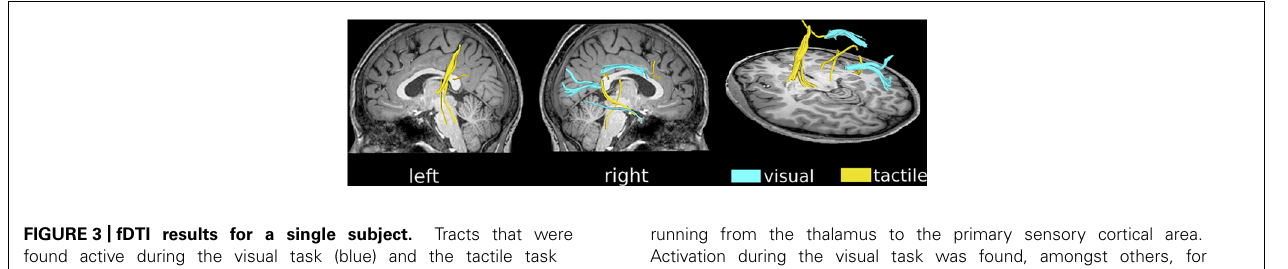
FIGURE 3 | fDTI results for a single subject. Tracts that were found active during the visual task (blue) and the tactile task (yellow) using the fDTI method. During the tactile task, activation was found predominantly contra-laterally for the thalamo-cortical tracts